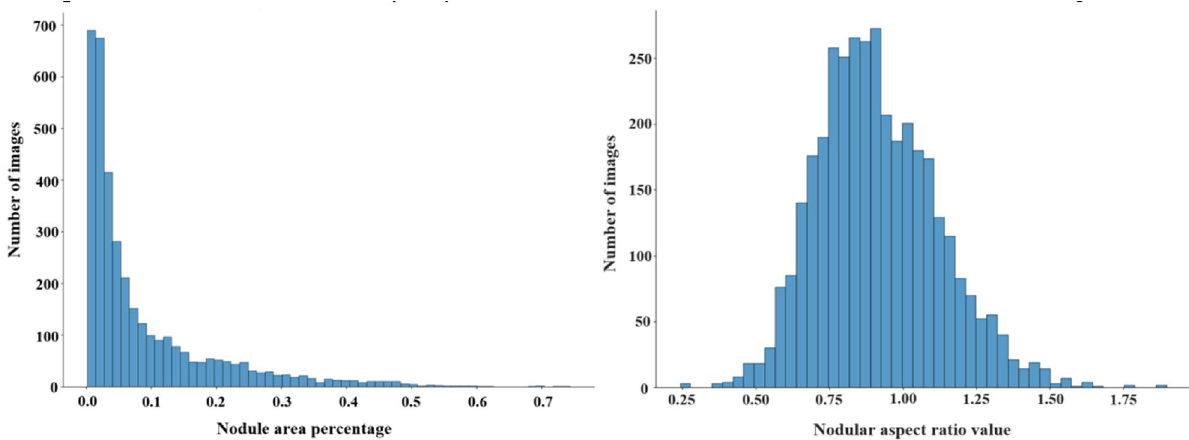
Figure 3. Statistical chart of nodule